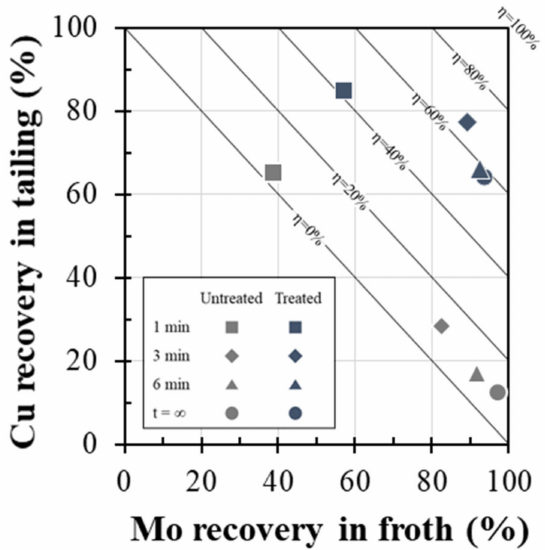
Figure 8. Relationship between Mo recovery in froth and Co recovery in tailing obtained in the mixed mineral